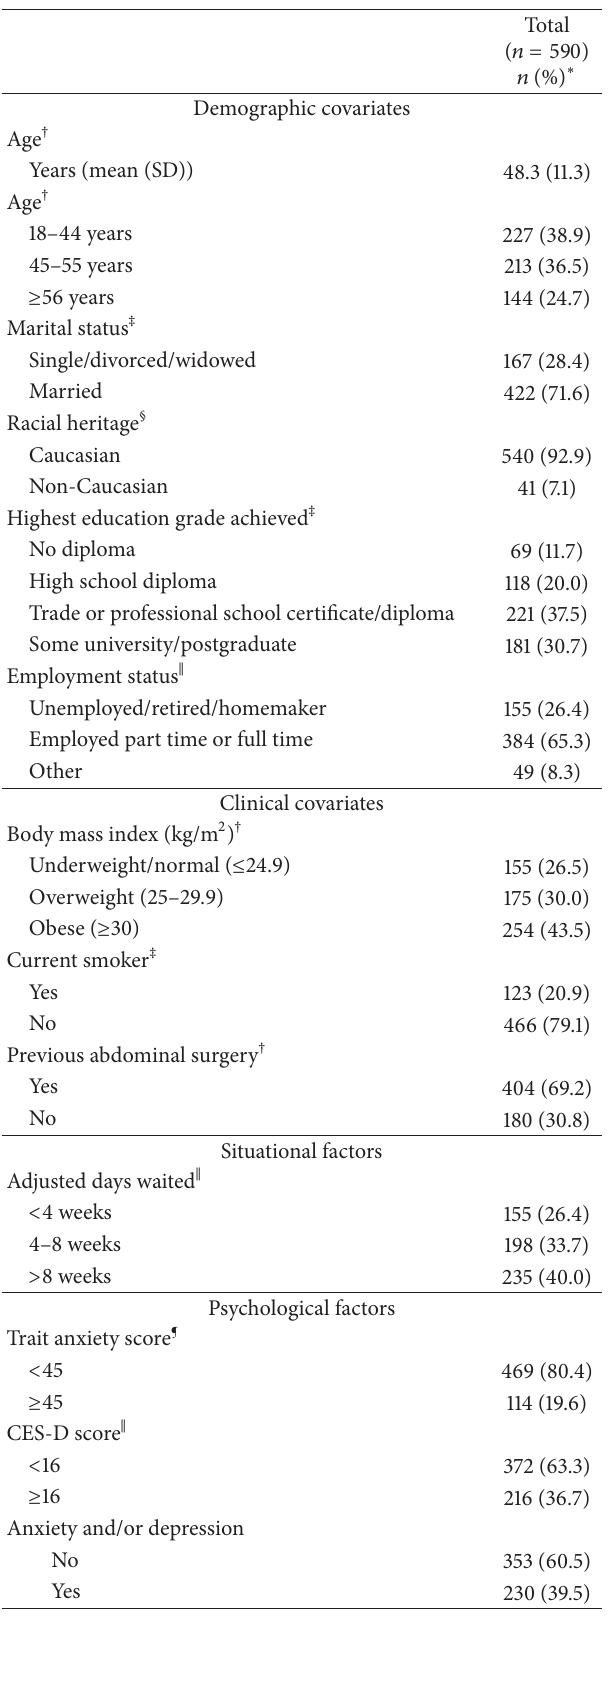
Table 1: Baseline characteristics of women waiting for gynaecolog- ical